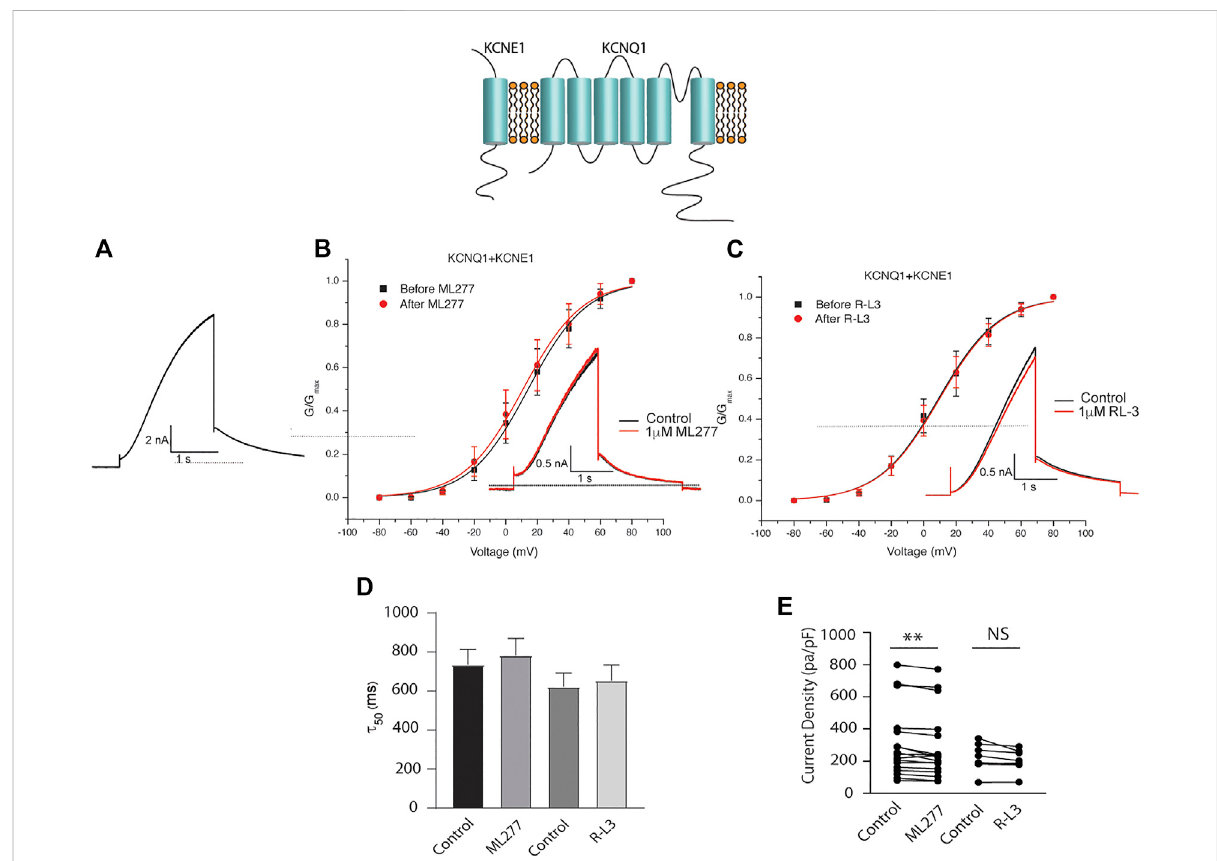
FIGURE 2 ML277 and R-L3 do not modulate IKS channels in the presence of KCNE1. Individual current traces recorded in response to 2 s depolarizing steps to +60 mV from (A) 70 mV holding potential are shown as insets in panels (B,C) in the absence (black) and presence (red) of test drugs. (A) . Control KCNQ1-KCNE1 channel activity recorded at +60 mV. (B) . KCNQ1-KNCE1 conductance-voltage curves in the absence (black) and presence (red) of 1 μ M ML277. (C) . KCNQ1-KNCE1 conductance-voltage curves inthe absence (black) and presence (red) of 1 μ M R-L3. (D) . Deactivation tail time constants measured at − 40 mV in the absence (control) and presence of 1 μ M ML277 and 1 μ M R-L3. (E) . Summary data for peak KCNQ1- KCNE1 current density measured at +60 mV in the absence (control) and presence of 1 μ M ML277 and 1 μ M R-L3. Data from individual experiments are connected by straight